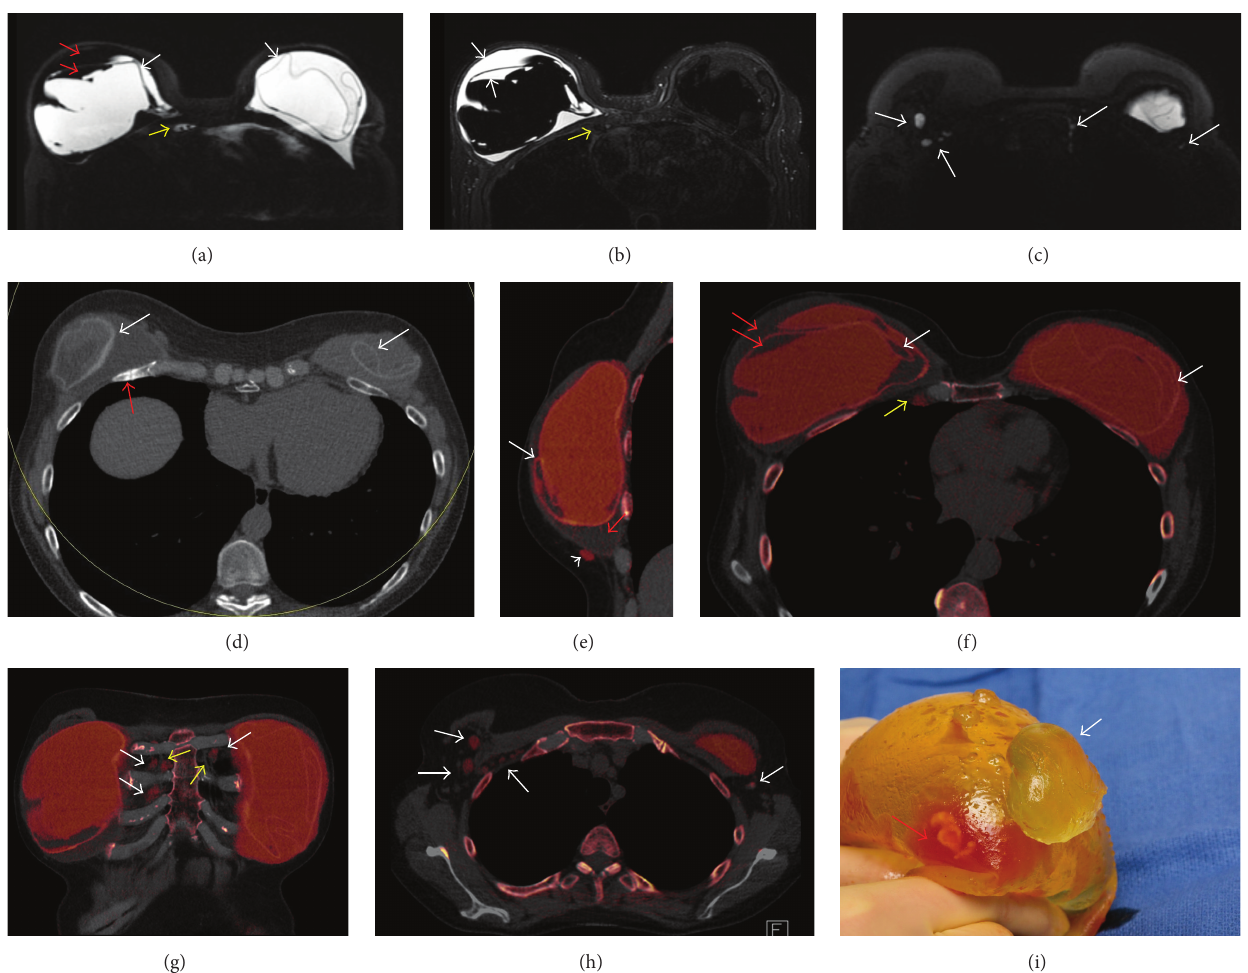
Figure 1: 62-year-old woman presents with enlarging right breast following a fall one month earlier and a history of long standing bilateral subpectoral silicone implants following left modified radical mastectomy and simple right mastectomy in 1992. (a) Axial silicone sensitive MR sequence shows bilateral MR linguini sign of intracapsular rupture (white arrows) with low signal intensity material both within the capsule itself, along with high signal intensity silicone, and within the collapsed right envelope (red arrows). The high signal intensity tissue adjacent to the right internal mammary (IM) vessels (yellow arrow) was not appreciated as being likely due to silicone due to the inhomogeneity of the fat and water suppression about heart. (b) T2 weighted axial IDEAL MR sequence shows high T2 signal fluid of intracapsular seroma within the right envelope (white arrows). There is low signal intensity tissue adjacent to the right IM vessels which in retrospect would be in keepingwithsiliconewithinaninternalmammarynode(yellowarrow).(c)Axialsiliconesensitivesequencefromthehighaxillademonstrates high signal intensity material which was not appreciated prospectively as right intranodal silicone in level I and II nodes and left IM nodes (arrows). (d) Axial mixed energy CT shows the CT linguini sign of collapsed implant envelopes bilaterally (white arrows). Healing fractured right anterior rib is clearly seen (red arrow). (e) Sagittal dual-energy noncontrast CT of the right breast with silicone colored as red shows intracapsular rupture with CT equivalent linguini sign of collapsed silicone envelope (white arrow). Water density material (red arrows) is noted surrounding the collapsed right envelope as seen on fluid sensitive MRI sequence (c). Extracapsular silicone is noted inferiorly (arrowhead). (f) Axial dual energy noncontrast CT of the right breast with silicone colored as red shows bilateral intracapsular rupture with CT equivalent linguini sign of collapsed silicone envelopes (white arrows). Water density material (red arrows) is noted surrounding and within the collapsed right envelope as seen on fluid sensitive MRI sequence (c). Silicone is also easily seen within enlarged right IM lymph node (yellow arrows). (g) Coronal DECT with color coding shows silicone within the right and left internal mammary nodes (white arrows). The internal mammary vessels can be seen (yellow arrows). (h) Axial DECT with silicone colored as red show silicone within right level I and II and left level I nodes (arrows). (i) Photograph of the explanted right implant with extruded silicone from the envelope (white arrow). Serosanguineous fluid noted within the envelope as seen on MRI and CT (red